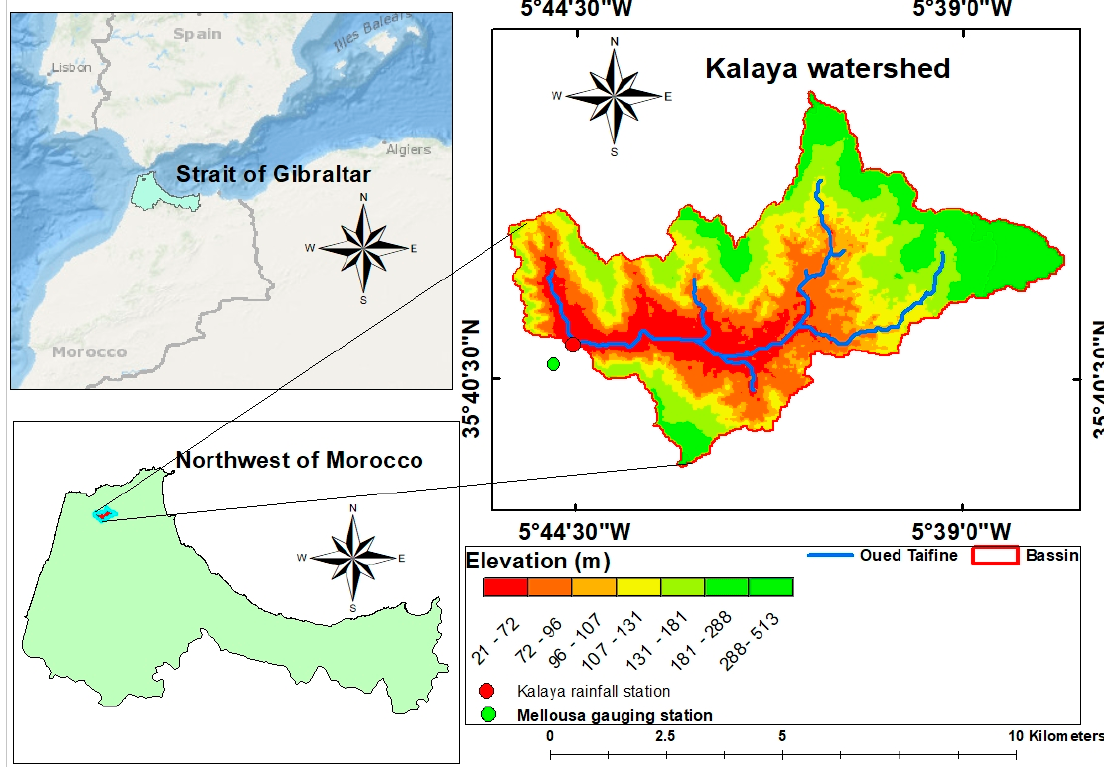
Figure 1. Location and digital elevation model (DEM) of the study area.